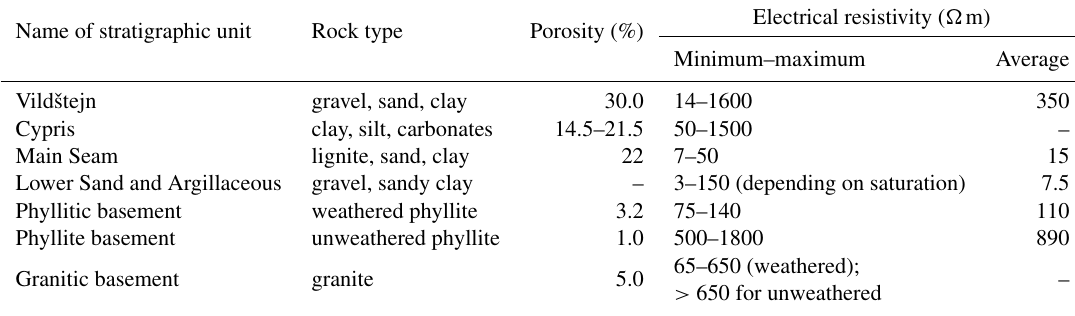
Table 1. Petrological description of the stratigraphic layers of sediments in the Cheb Basin and the basement below, translated from Dobeš et al.